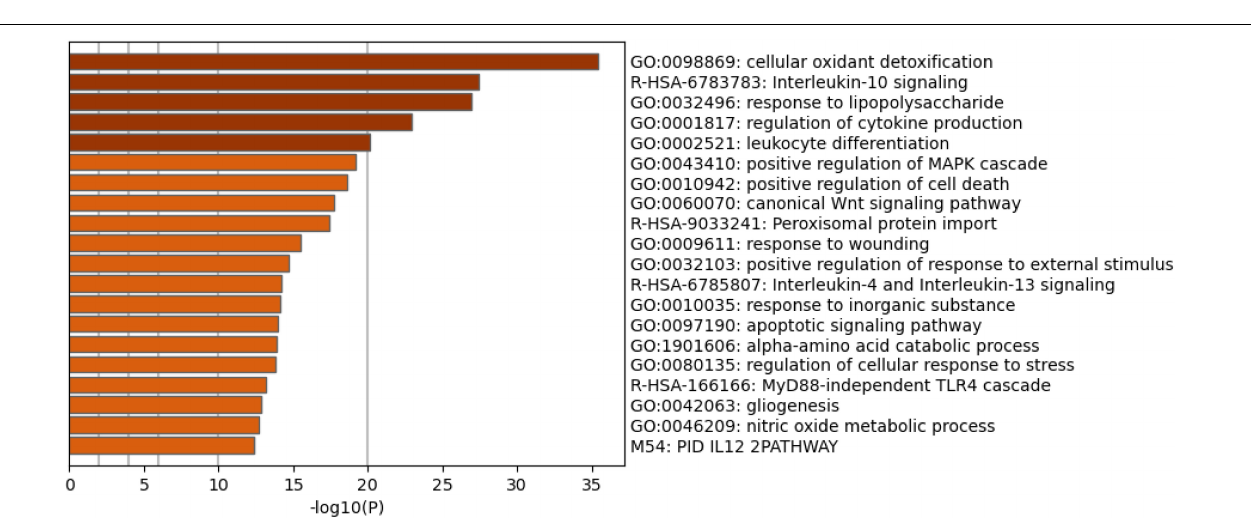
FIGURE 3 | Results of OmicsNet analysis, which included all the genes of the network with integration of the metabolics and NFKB1. Metabolics are shown in yellow color and NFKB1 is shown in green color. 3HK: 3-hydroxykynurenine; NO: nitric oxide; EPA: eicosapentaenoic acid.